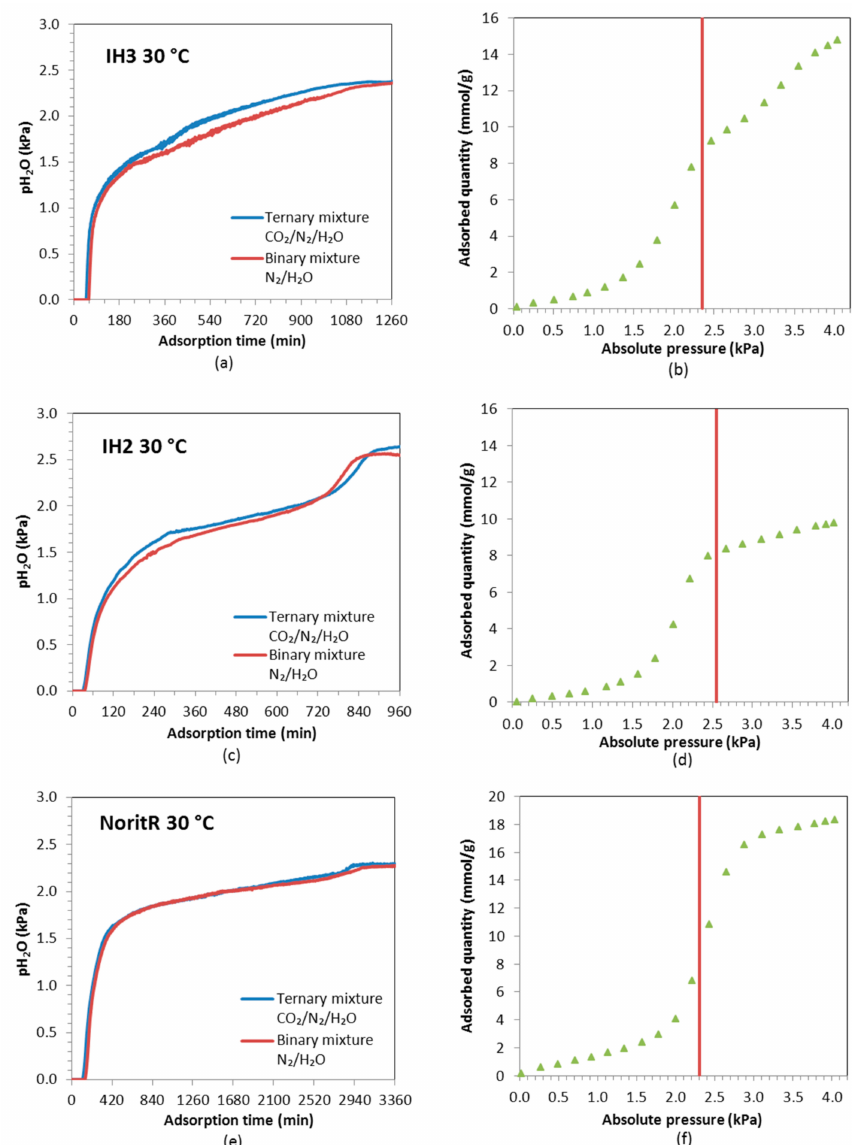
Figure 10. Water vapor breakthrough curves at 30 ◦ C for a ternary N 2 /CO 2 /H 2 O mixture (blue) and a binary H 2 O/N 2 one (red) on: ( a ) IH3; ( c ) IH2; and ( e ) Norit R. Water vapor adsorption isotherms at 30 ◦ C for: ( b ) IH3; ( d ) IH2; and ( f ) Norit R. The red vertical line indicates the partial pressure of H 2